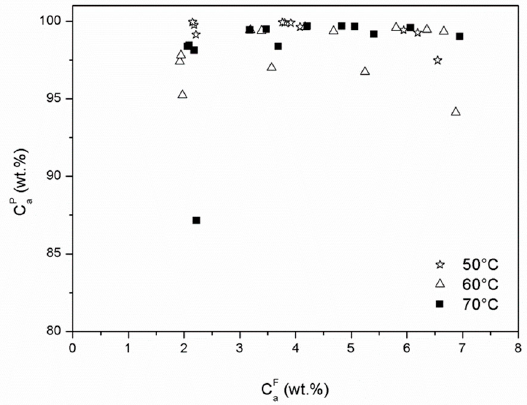
Figure 5. Concentration of water in the feed and permeate for different temperatures.